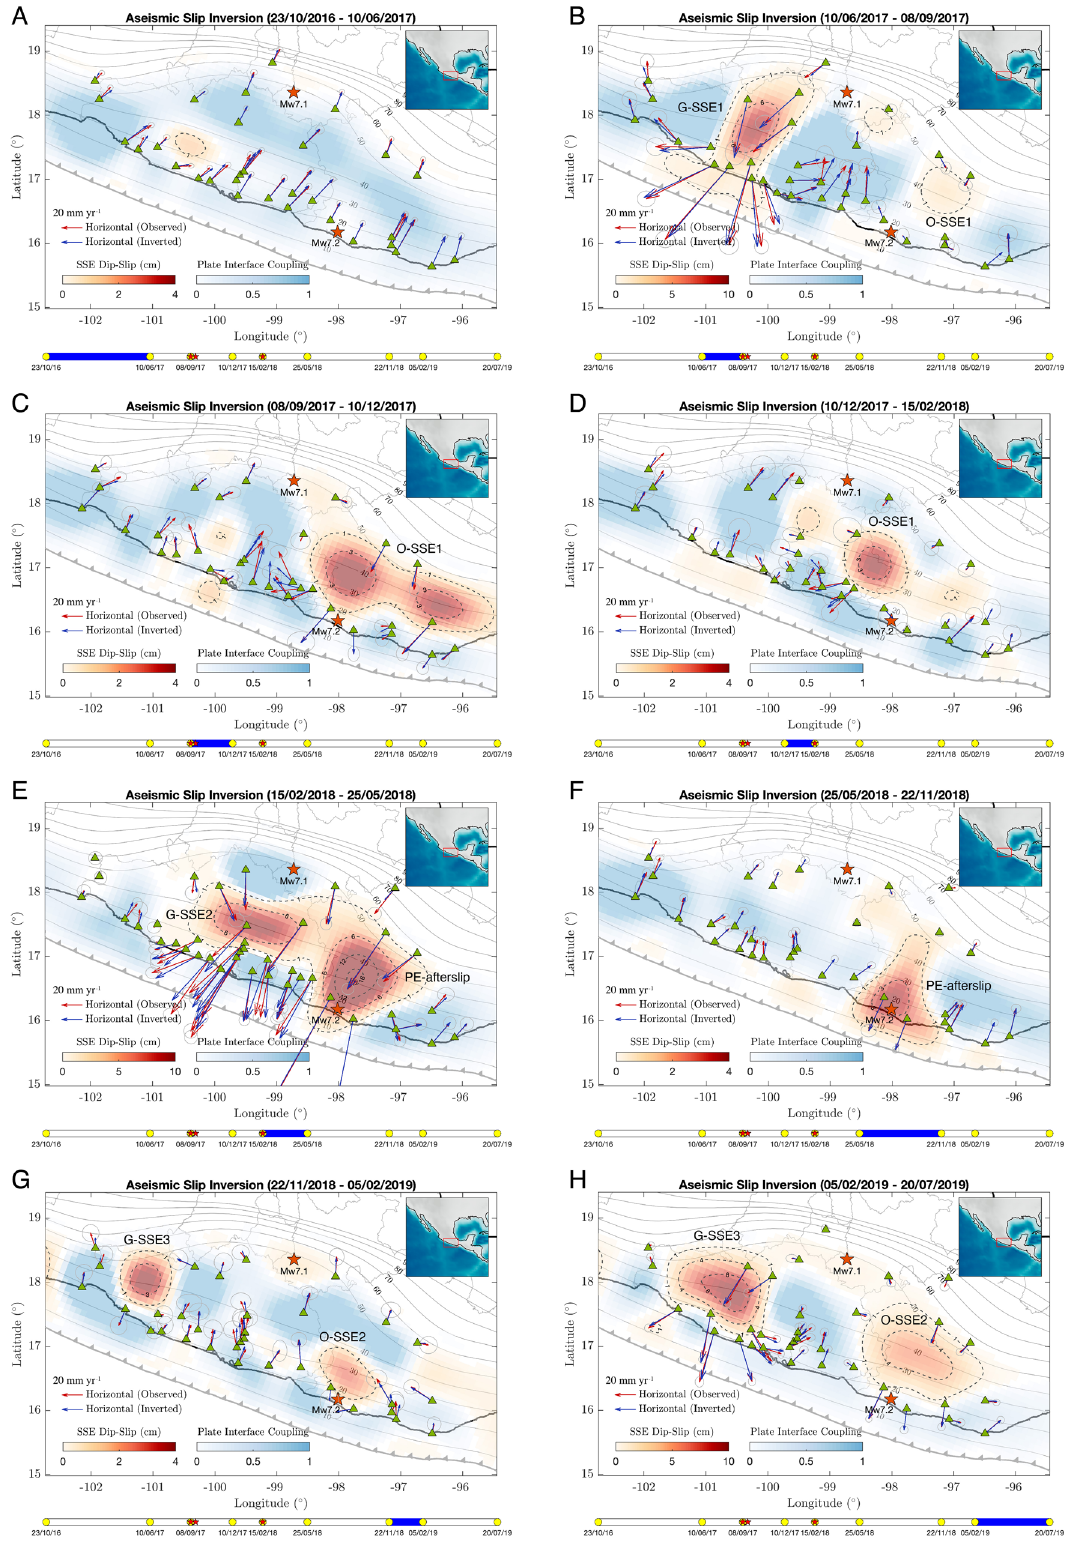
(Table 1). The aseismic slip evolution for all time windows is summarized in Fig. 3A and integrated into